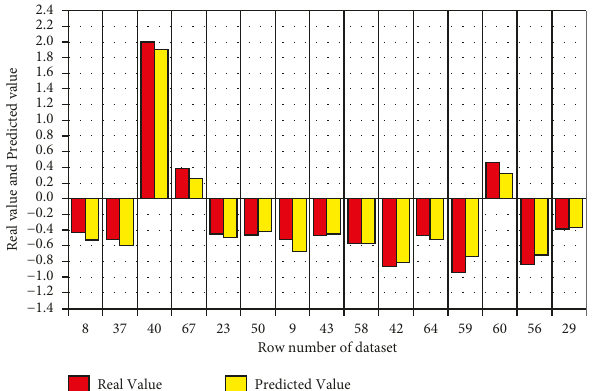
Figure 15: Comparison between real values and predicted values of Aman yield for XGBoost.